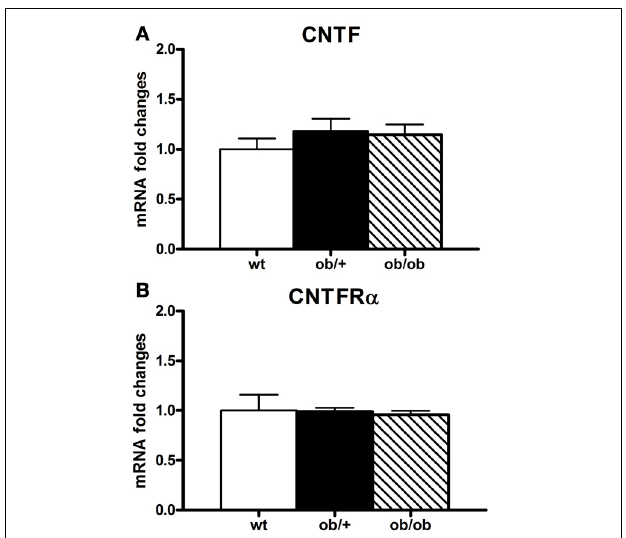
FIGURE 7 | RT-PCR analysis of CNTF (A) and CNTFR α (B) in the hypothalamus of wild type (wt), ob / + and ob / ob mice. Mean ±